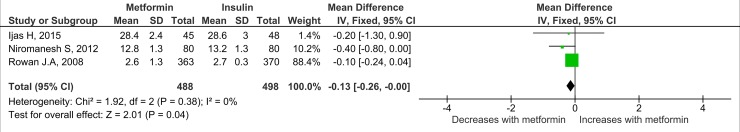
Neonatal ponderal index.Expressed as mean difference (fixed effects model) and 95% CI. IV, mean difference.